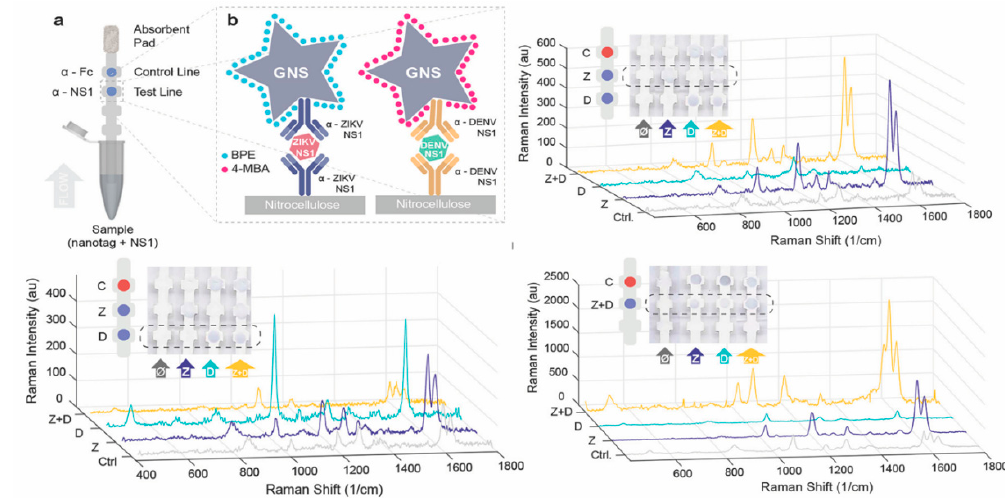
Figure 6. Multiplexed SERS-based indirect detection of Zika and dengue using dipstick sandwich immunoassay. (top left) Schematic diagram of dipstick immunoassay where sandwiches are formed by each antibody pair, NS1, and gold nanostars–Ab conjugate for both ZIKV and DENV NS1. SERS spectra of (top left) Zika and (bottom left) dengue test line separately and (bottom right) both Zika and dengue in the same test line. Samples: The control (C) (gray), ZIKV NS1 (blue), DENV NS1 (cyan), and a mixture of ZIKV and DENV NS1 (yellow). Reproduced with permission from Reference [102] American Chemical Society